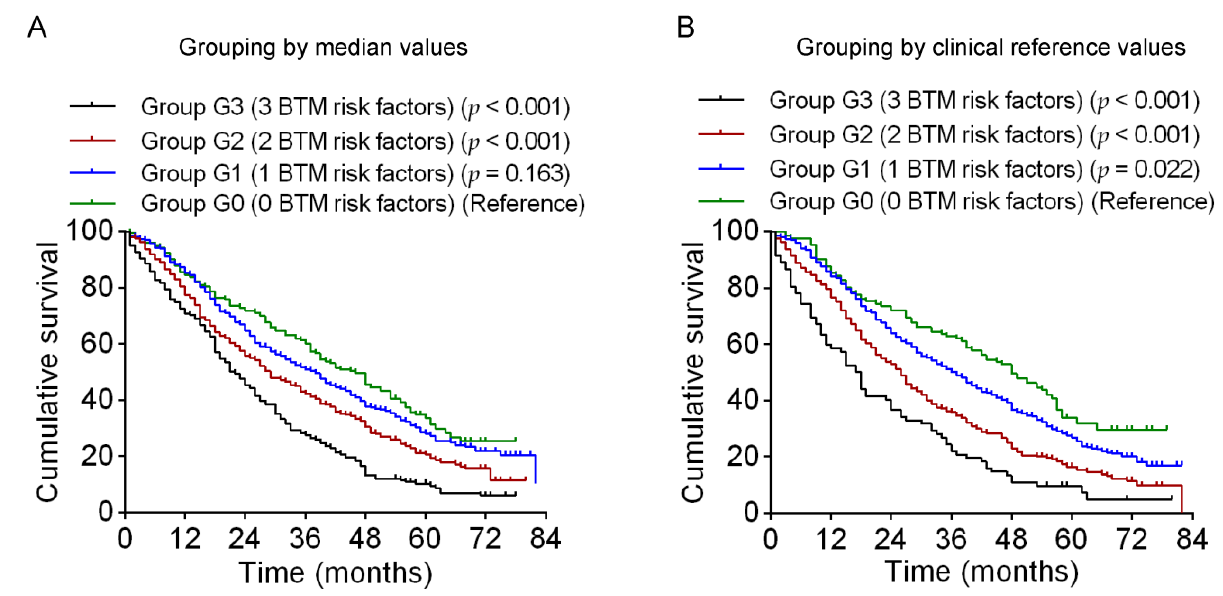
Figure 4. Kaplan–Meier plots and results of log-rank tests for the associations of all-cause mortality with the combined risk factors of lower 25(OH)D, higher PTH, and higher β-CTX. Centenarians were categorized into the four following subgroups: G0, no risk factors; G1, one risk factor; G2, two risk factors; G3, all three risk factors of ( A ) 25(OH)D < 21.5 ng/mL, PTH > 43.89 pg/mL, and β-CTX ≥ 0.406 ng/mL or ( B ) 25(OH)D < 30 ng/mL, PTH > 65 pg/mL, and β-CTX ≥ 0.55 ng/mL. 25(OH)D, 25- hydroxyvitamin D; β-CTX, β-C-terminal telopeptide of type 1 collagen; BTM, bone turnover mark- ers; PTH, parathyroid hormone. Table 3. Cox regression analyses for the associations of all-cause mortality with the combined risk factors of low 25(OH)D, high PTH and β-CTX levels in centenarians.